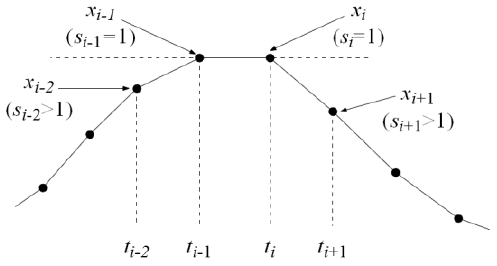
Figure 5. An example of special case of a “flat” peak consisting of two equal values at t i -1 and t i .